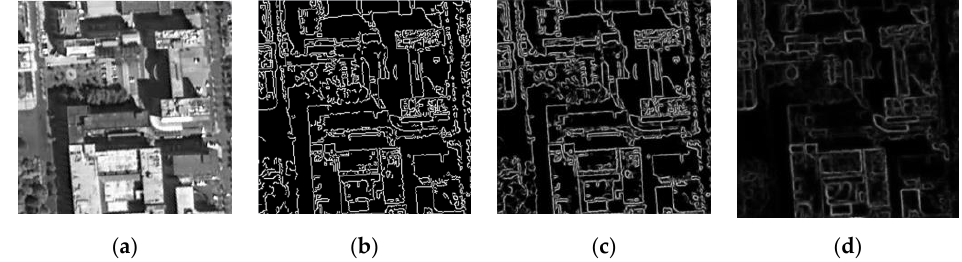
Figure 4. Comparison of different feature extraction methods: ( a ) Grid cell after preprocessing, ( b ) edge detected by Canny operator, ( c ) edge detected by the method in [13], ( d ) robust edge detected by MUM-Net.